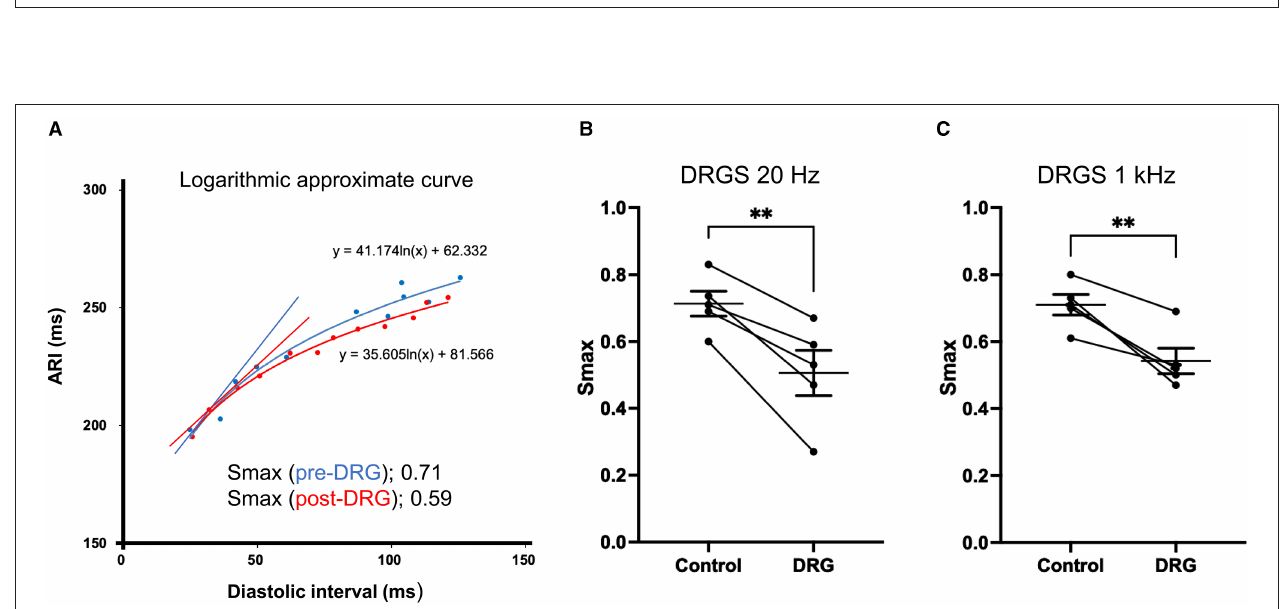
FIGURE 5 | Representative electrical restitution curve and global ventricular maximum slope (S max ). (A) Representative figure of electrical restitution curve showing the decrease in maximum steep slope (Smax) after 30min of dorsal root ganglion stimulation (DRGS) compared to pre-DRG. Thirty min of DRGS at 20Hz or 1kHz decreased S max with significant differences [ ** P = 0.0061 at 20Hz on the left figure (B) , ** P = 0.0069 at 1kHz on the right figure (C) ]. The data are reported as mean ± standard error (SE).